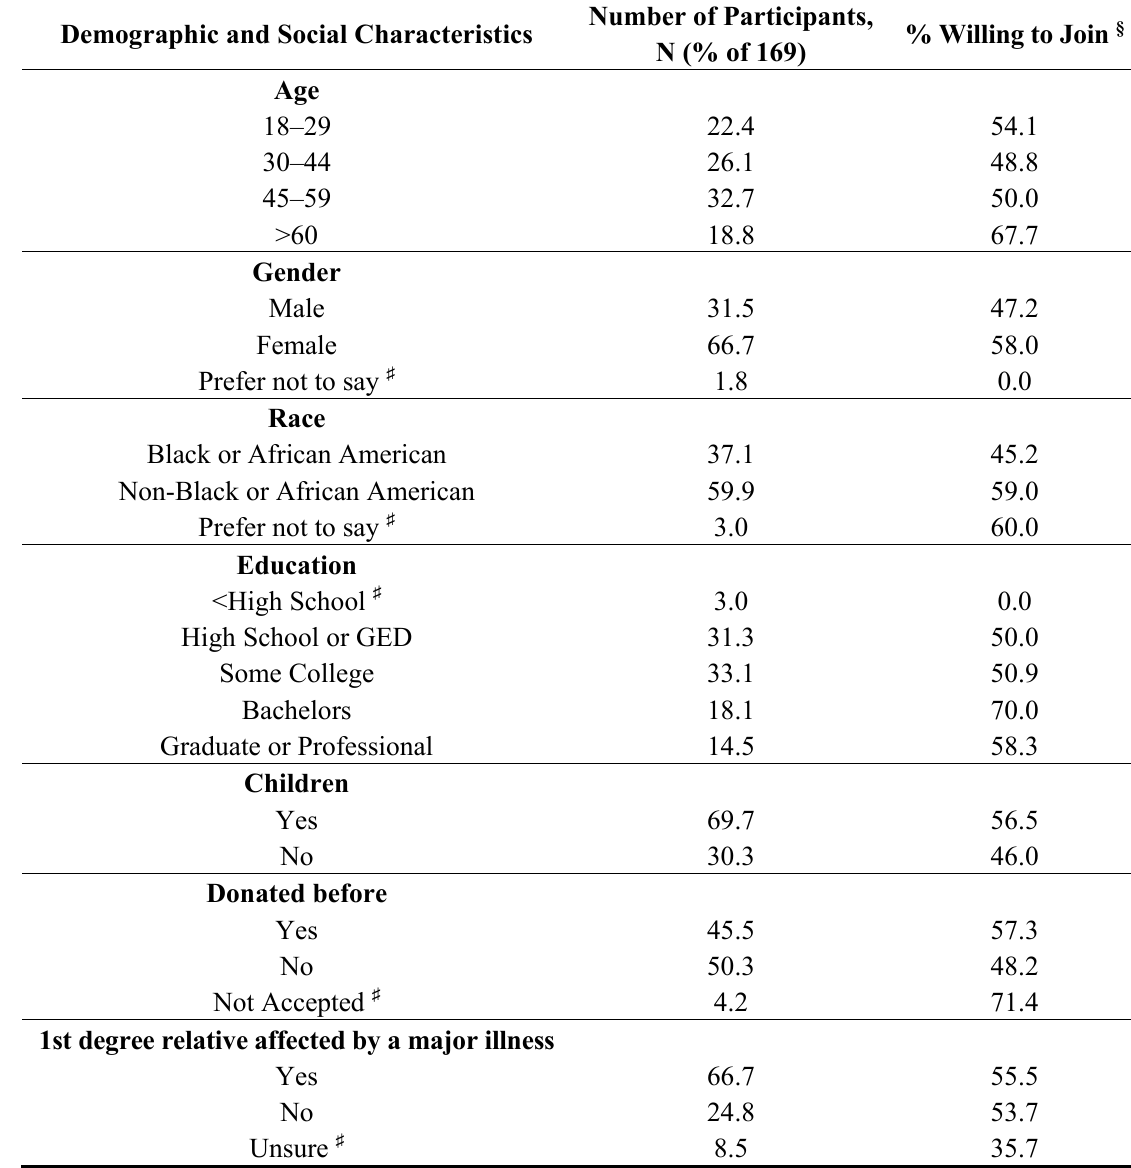
Table 1. Percent of survey completers (out of 169 total) willing to join the UMBiobank, according to demographic and social